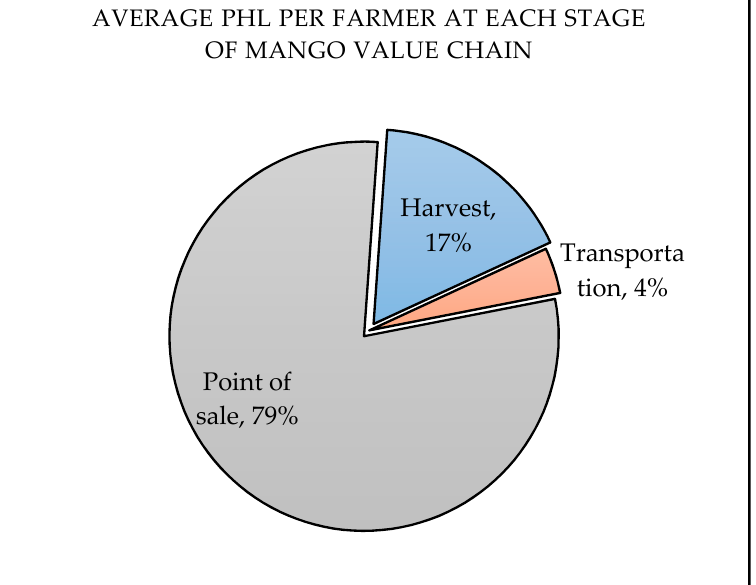
Figure 2. Proportion of PHL at each value chain stage.